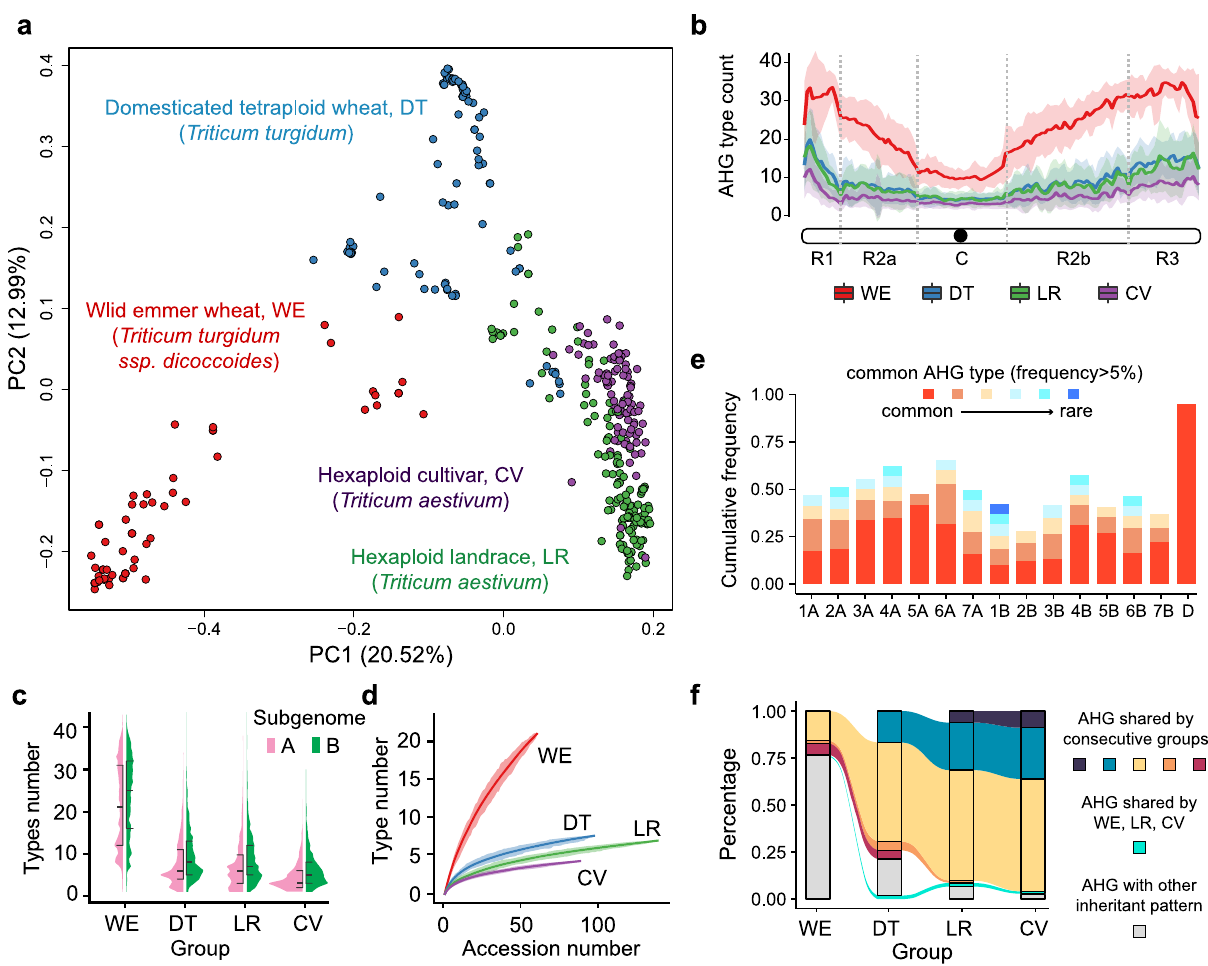
Fig. 2 AHG reveals the transition of gene pools in polyploid wheat. a Principal component analysis plot constructed with AHG-based distances for all 5-Mb windows in A&B genomes. b Counts of AHG types across chromosome model of A&B subgenomes. Solid line and colored area, mean±sd. WE, wild emmer wheat. DT, domesticated tetraploid wheat. LR, hexaploid wheat landrace. CV, hexaploid wheat cultivar. The chromosomal zones R1, R2a, C, R2b and R3 are consistent with previous publication 32 . c Violin plot showing the count distributions of AHG types in the A&B subgenomes for each group. d Saturation curves showing the cumulative number of AHG types versus the number of accessions included. Solid line and shaded region, average and 90% con fi dence intervals for 14 A&B chromosomes. e Stacked bar graph showing the frequency and corresponding order of common AHGs (frequency > 5%) by chromosome. “ D ” indicates the average value of 7 chromosomes in D subgenome. f Proportion of shared AHGs among four taxonomic groups shown by alluvial plot revealed genetic fl ows through the route of WE-DT-LR-CV. A dramatically higher proportion of AHGs in the hexaploid groups can be traced back to the DT group than to the WE group using the collected samples, indicating DT as the closest gene pool for hexaploid wheat. Source data are provided as a Source Data fi